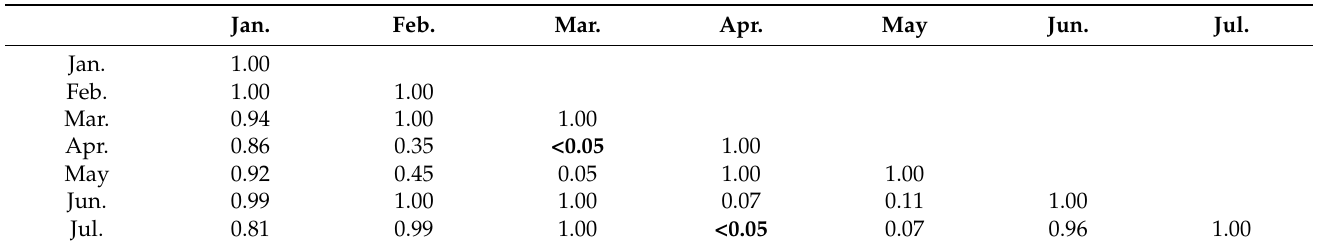
Table 2. p -values for Tukey multicomparison tests of the ANOVA analysis standard distance~month. Significant p -values are shown in boldface type.